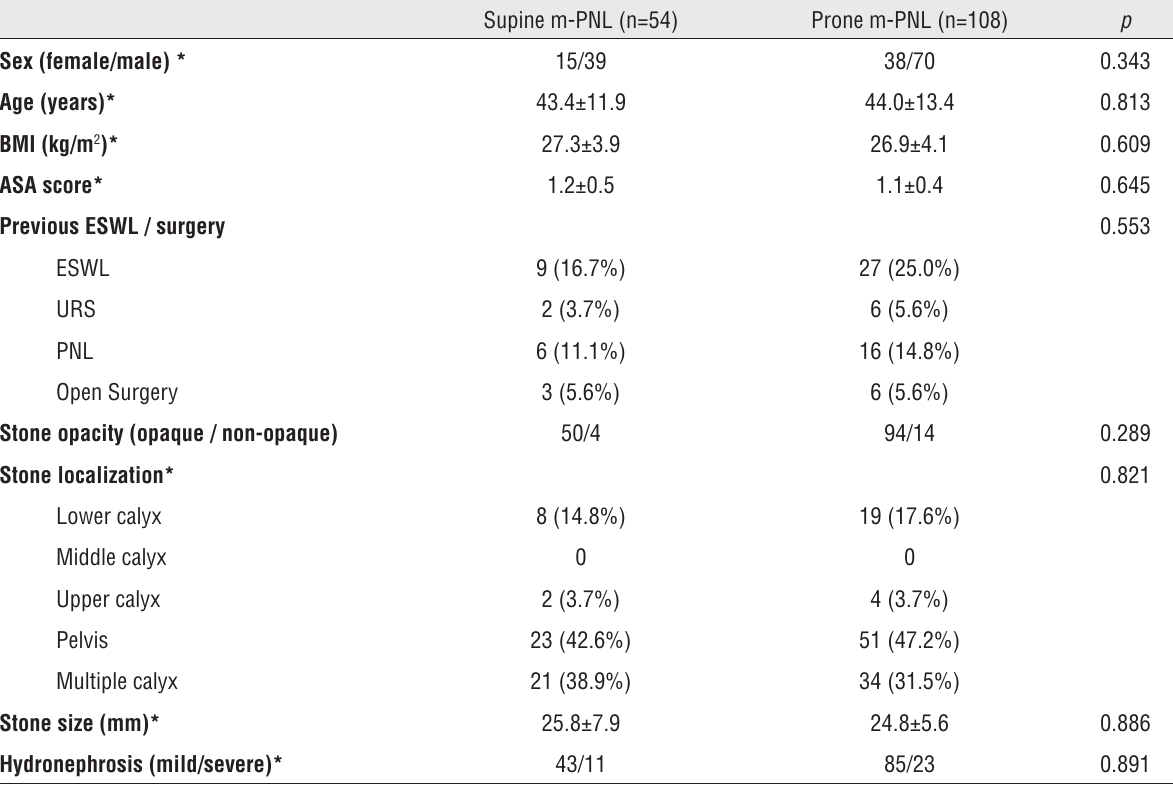
Table 1 - Demographic data and stone